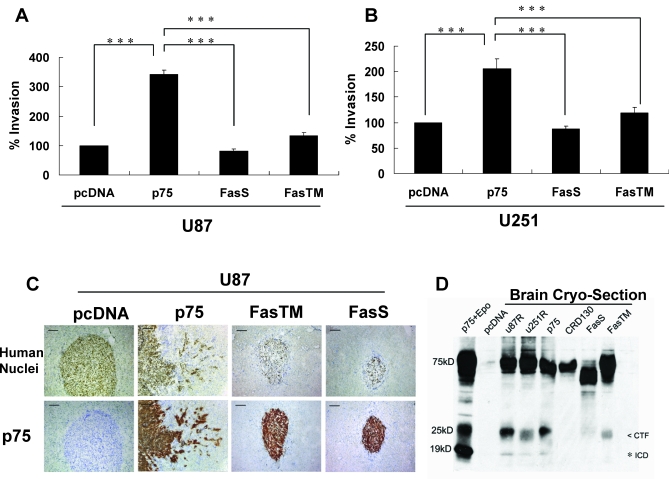
Cleavage-Resistant Chimeric p75NTR Proteins Do Not Induce Migration and Invasion In Vitro or In Vivo(A and B) The invasive ability of U87 (A) and U251 (B) stably transfected with p75NTR or the p75NTR cleavage-resistant chimeric constructs (p75FasS and p75FasTM) were assessed using 3D-invasion assays. Expression of p75NTR significantly increased invasion in the genetically distinct glioma cell lines U87 and U251, whereas neither p75FasS nor p75FasTM stimulated glioma invasion as compared to the p75NTR-negative control cells (pcDNA). Values shown are the mean ± s.e.m. from three independent experiments; (the less than symbol [<] indicates CTF; the asterisk [*] indicates ICD; triple asterisks [∗∗∗] indicate p < 0.001 vs. p75NTR wild type, one-way ANOVA with Neuman-Keuls post-test).(C) U87 cells stably expressing p75NTR or the cleavage-resistant p75FasS and p75FasTM were implanted into the brains of SCID mice and allowed to grow for 28 d. The mice were sacrificed, and frozen brain sections were stained with antibodies against human nuclei (top row, brown) and human p75NTR (bottom row, brown). Sections were counterstained with toluidine blue (blue). Scale bars in (C) represent 100 μm. Implantation of U87 glioma cells stably transfected with the empty pcDNA vector or p75NTR cleavage-resistant chimeras (p75FasTM and p75FasS), led to the formation of well-circumscribed tumors. In marked contrast, animals implanted with U87 glioma cells ectopically expressing p75NTR (U87p75) developed tumors with highly infiltrative edges. Similar results were seen in three independent experiments with three animals in each group.(D) p75NTR cleavage-resistant chimeras do not generate ICD in vivo. Brain cryosections from SCID mice implanted with U87 glioma cells expressing p75NTR, p75FasTM, or p75FasS were lysed in 2× loading buffer. Proteins were resolved on 10% SDS-PAGE gels and probed with a p75 cytoplasmic-specific antibody. U87R, U251R, and U87p75, which express high levels of p75NTR and exhibit increased invasive activity, process full-length p75NTR to generate both CTF and ICD in vivo. In contrast, and consistent with the in vitro data, the p75NTR ICD peptide was not detected in tumors from animals expressing p75FasS or p75FasTM. Cell lysates from U87 cells expressing p75NTR and grown in the presence of epoxomicin (p75NTR+Epo) or expressing pcDNA (pcDNA) were used as positive and negative controls, respectively.